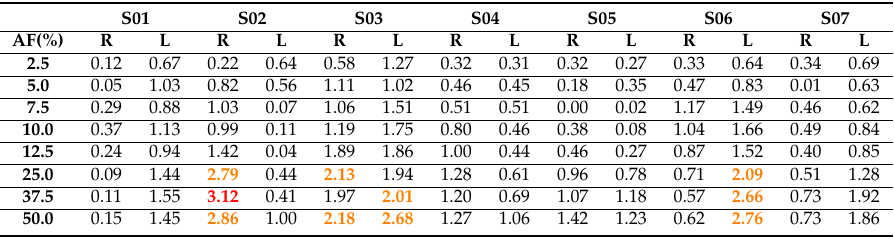
Table 2. Dispersion ratio R computed in seven subjects (S01-S07) with Equation (8) for right (R) and left (L) classes at different levels of used artificial frames (AF). Results with R > 3 are highlighted in red and with 2 < R < 3 in